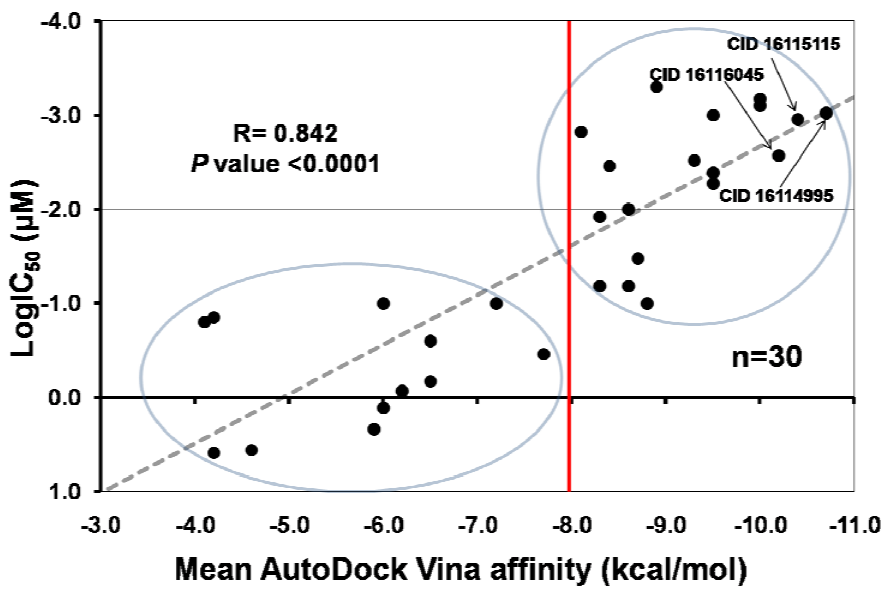
Figure 2. Correlation between the mean affinities calculated by AutoDock Vina in 3E7G and 1NSI for iNOS inhibitors, and their half maximal inhibitory concentration [LogIC The regression line (Y = 0.375X + 1.820) was added for illustrative purposes. Circles show molecules with high (upper) and low (lower) biological